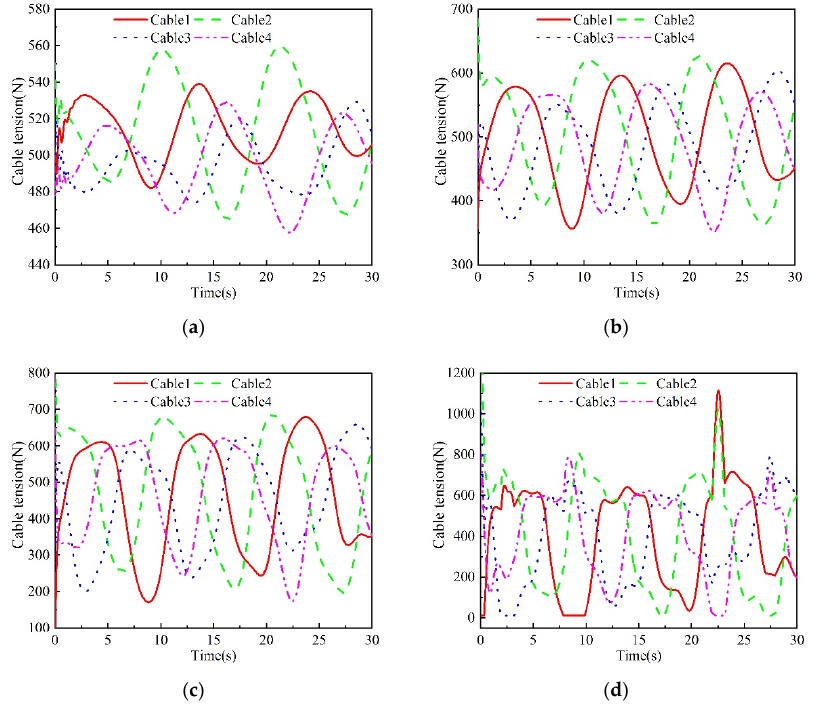
Figure 9. Cable tensions at different speeds: ( a ) Low-speed motion v = 0.6 m/s; ( b ) Medium speed motion v = 3.1 m/s; ( c ) High-speed motion v = 6.3 m/s; ( d ) Ultra-high-speed motion v = 9.4 m/s.